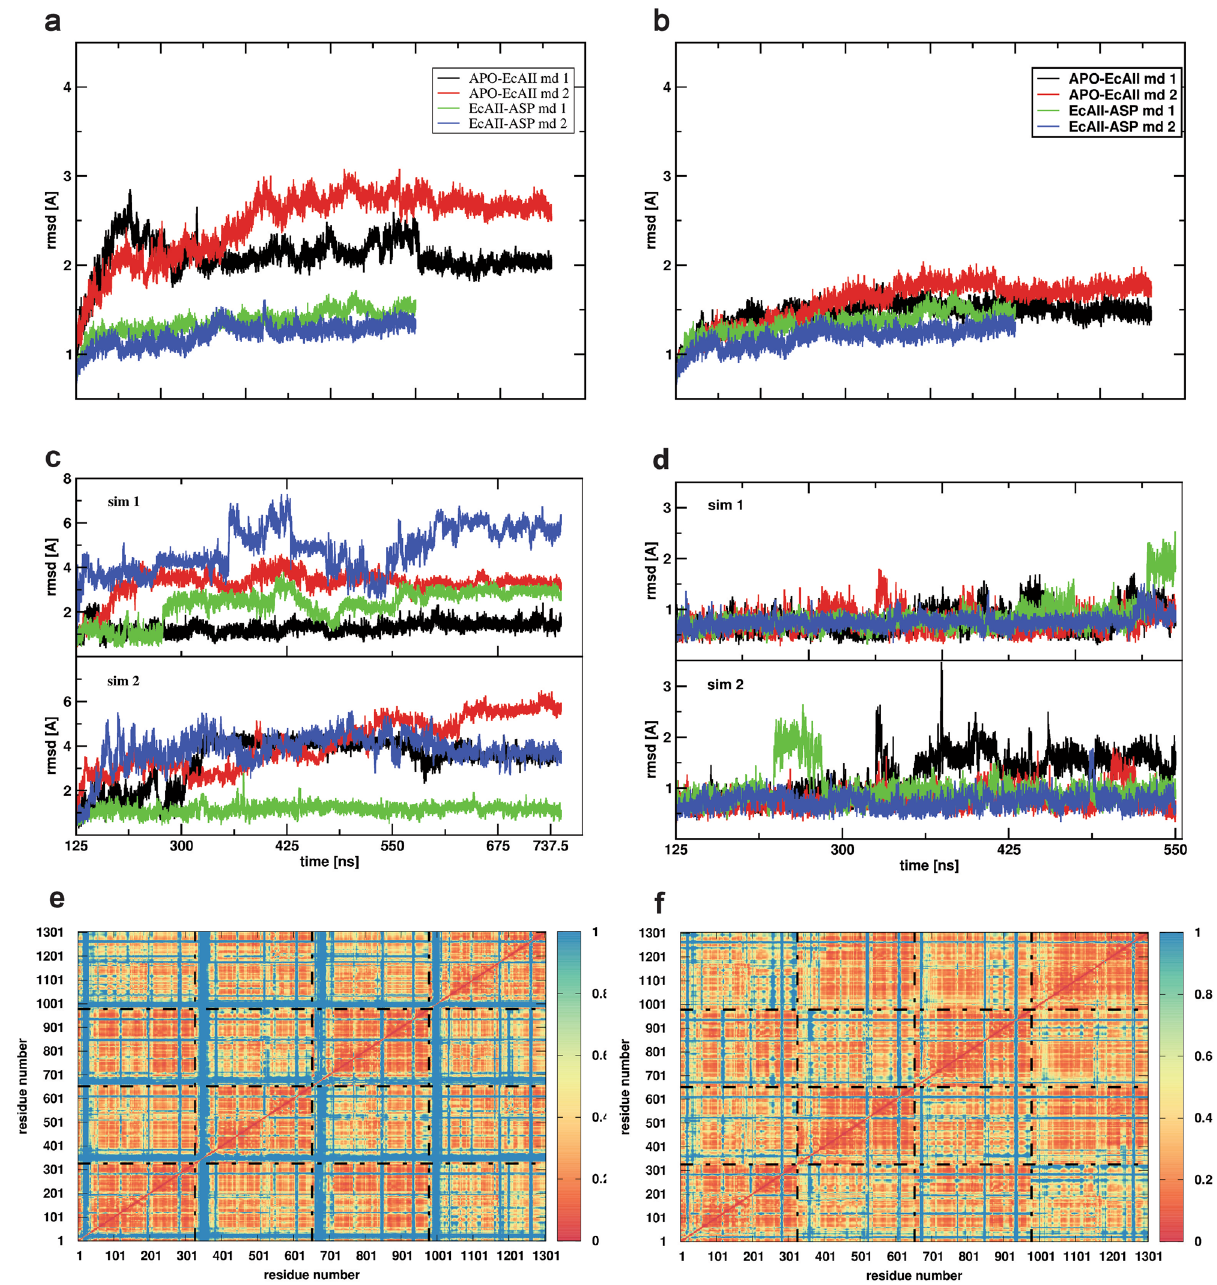
Figure 5. Dynamics of APO and EcAII-ASP. Root-mean-square deviation of atomic positions along the simulation: ( a ) on all Cα of l-asparaginase without (APO) and with l-Asp present in the catalytic site. ( b ) Same as a without the Cα that belong to the catalytic loop. ( c ) Catalytic loop without l-Asp in the catalytic site (APO form). ( d ) Same as ( c ) with l-Asp in the catalytic site (HOLO form). ( e ) and ( f ) Distance Fluctuation matrices for EcAII with ( f ) and without ( e ) l-Asp in the catalytic out of 10 stabilized residues belong to the protomer C-domain, in particular to the region in proximity of the catalytic E283 ′ residue, pointing at an inter monomers stabilization induced by the ligand. Analysis of the contacts formed during the MD simulation between the active site flexible loop residues and the rest of the protein was carried out next. A residue of the catalytic loop is considered to establish a “stable” contact with other residues of the protein if the distance between their Cα atom is lower than 6 Å for more than 30% of the total of sampled conformations (total conformations obtained by combining the data from the two simulation runs for each system). In Table 1, we report the most important contacts established in APO-EcAII and EcAII-ASP during the MD simulation according to this criterion. Overall, only 16 (bold) out of the 53 EcAII- ASP contacts are maintained in the APO-EcAII form. Interestingly, contacts between the active site flexible loop